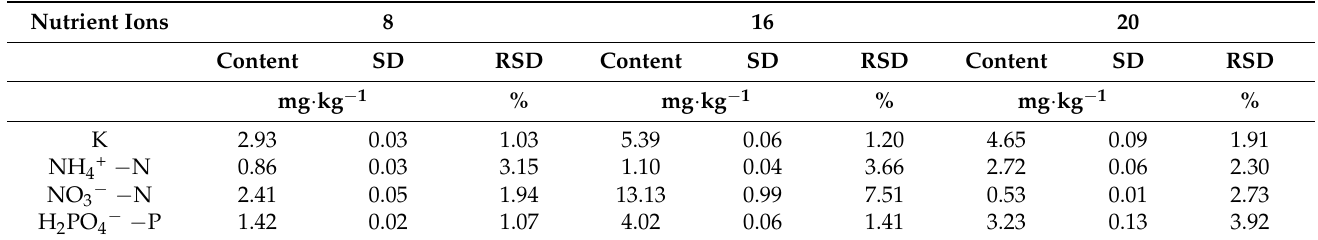
Table 1. Detection results of 3 lime concretion black soil samples macronutrients.